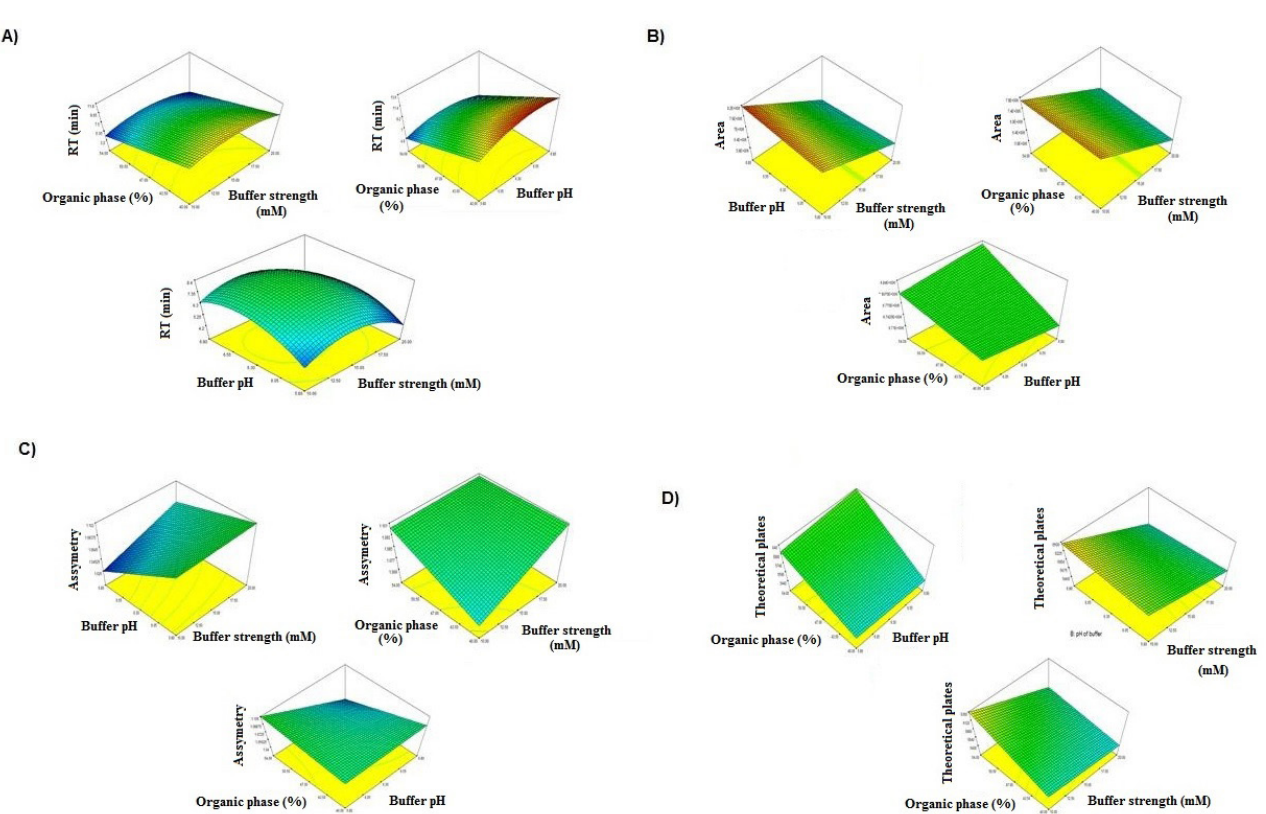
FIGURE 1 - Surface response graphs of A) Retention time as a function of pH, buffer strength and organic ratio B) Area as a function of pH, buffer strength and organic ratio C) Asymmetry as a function of pH, buffer strength and organic ratio D) Theoretical plates as a function of pH, buffer strength and organic